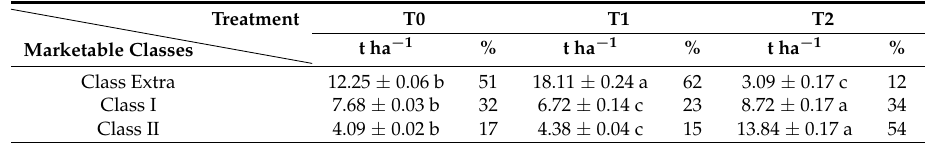
Table 5. Total yield distribution (t ha − 1 ) and its percentage according to the cutting type used for the artichoke vegetative propagation in relation to UNECE